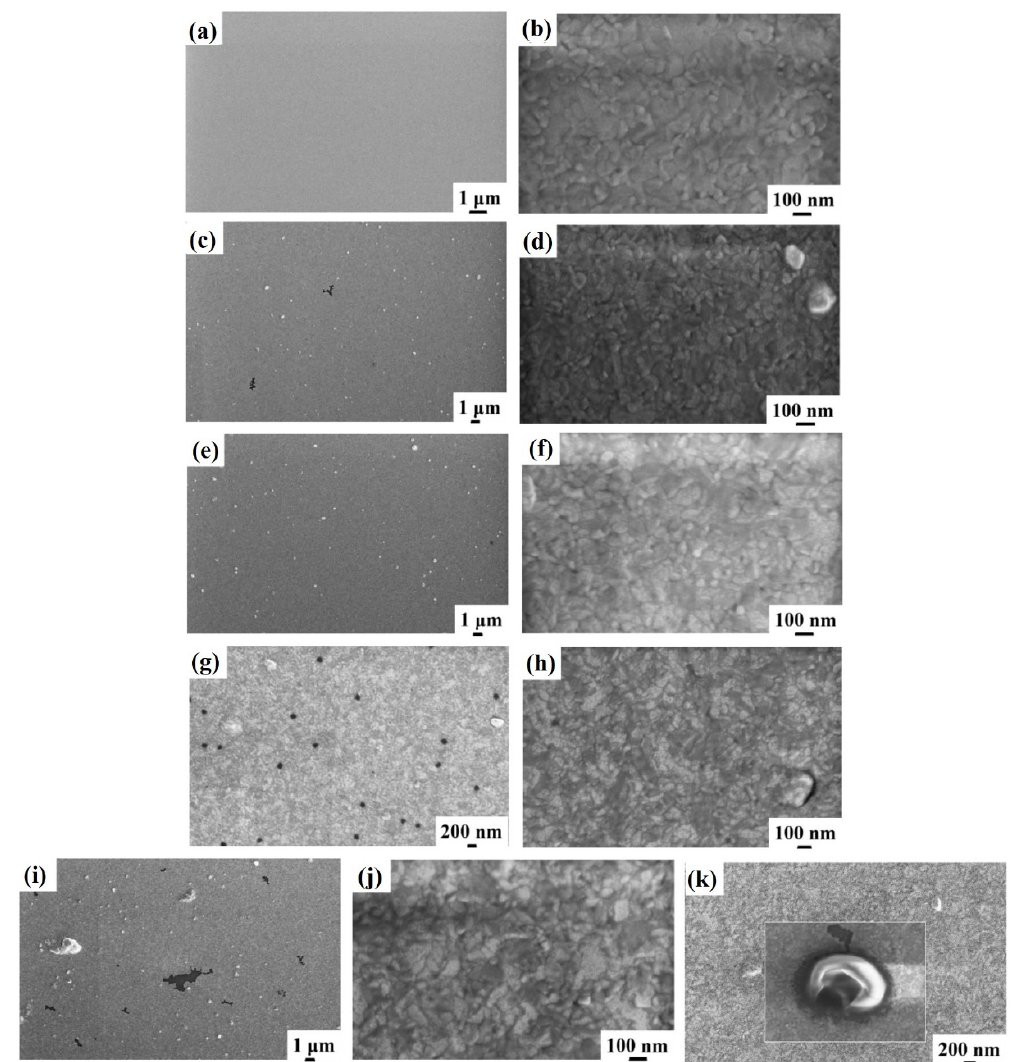
Figure 7 . Representative plan-view SEM images of the Al surface for the sample: ( a , b ) 4A (Si/WN/Al) with increasing magnification from ( a ) to ( b ); ( c , d ) 4E (Si/WN/Al + 350 °C 30 min) with increasing magnification from ( c ) to ( d ); ( e , f ) 4F (Si/WN/Al + 400 °C 15 min) with increasing magnification from ( e ) to ( f ); ( g , h ) 4G (Si/WN/Al + 450 °C 15 min) with increasing magnification from ( g ) to ( h ); ( i – k ) 4H (Si/WN/Al + 500 °C 15 min) with increasing magnification and highlighting some surface features as a holes in the Al layer as in ( k ).